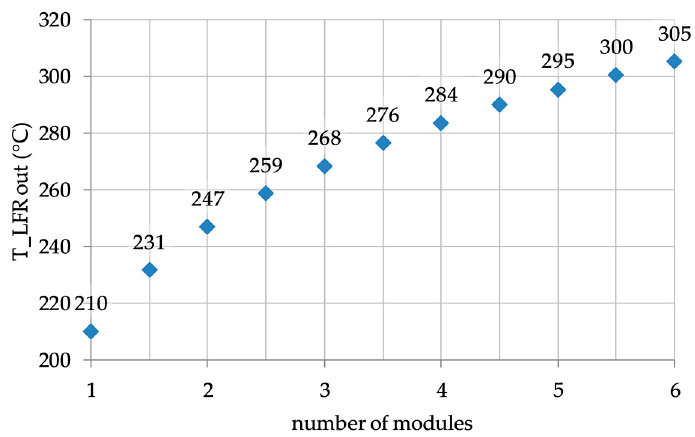
Figure 3. Logarithmic correlation between number of modules and LFR output temperature. The function is T_LFR out = 210 + log_b(m), where m = 1. n (number of modules) and b = 6^(1/(Tmax-210)) with Tmax the maximum temperature with all modules connected is 305 °C.